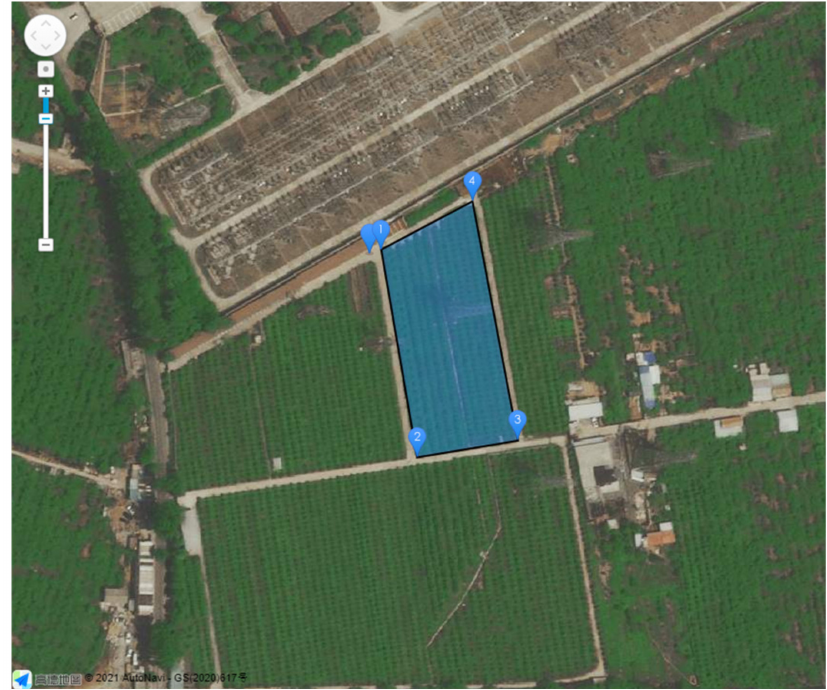
Figure 6. The vertices of the convex polygon operation region and the takeoff point. The unnumbered marker represents the takeoff point, while the numbered markers represent the vertices of the operation region. The blue convex polygon with a black border is the operation region.